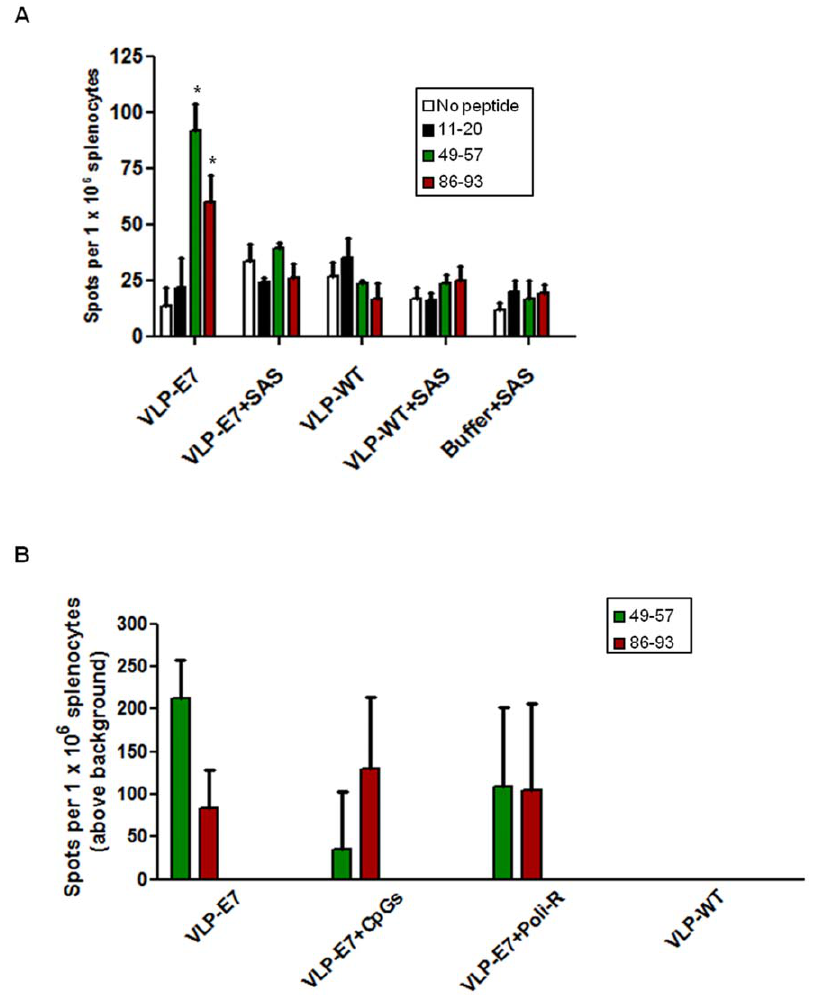
Figure 2. Immunization with VLP-E7 elicits E7 peptide–directed IFN- c –secreting splenocytes. A) IFN- c –secreting splenocytes from mice (n=5) immunized twice with either 50 m g of VLP-E7 or VLP-WT or PBS, with or without Sigma Adjuvant System (SAS), were quantified ex vivo by ELISPOT assay. The splenocytes were pooled from each group of mice, plated, and either not stimulated (no peptide) or stimulated with control peptide (11–20) or with two E7 peptides (49–57, H2 b epitope and 86–93 HLA-A2 epitope). Bars represent mean 6 s.e.m. of six replicates. * p , 0.05 compared with VLP-WT. B) IFN- c –secreting splenocytes from mice (n=5) immunized twice with either 50 m g of VLP-WT or 50 m g of VLP-E7 alone or with adjuvants (50 m g CpGs or 50 m g Poly-R) were quantified by ELISPOT assay. The splenocytes were pooled from each group of mice, plated, and stimulated as in A. The background values (no peptide and peptide control wells) were subtracted from those stimulated with the 49–57 and 86–93 E7 peptides. Bars represent mean 6 s.e.m. of six